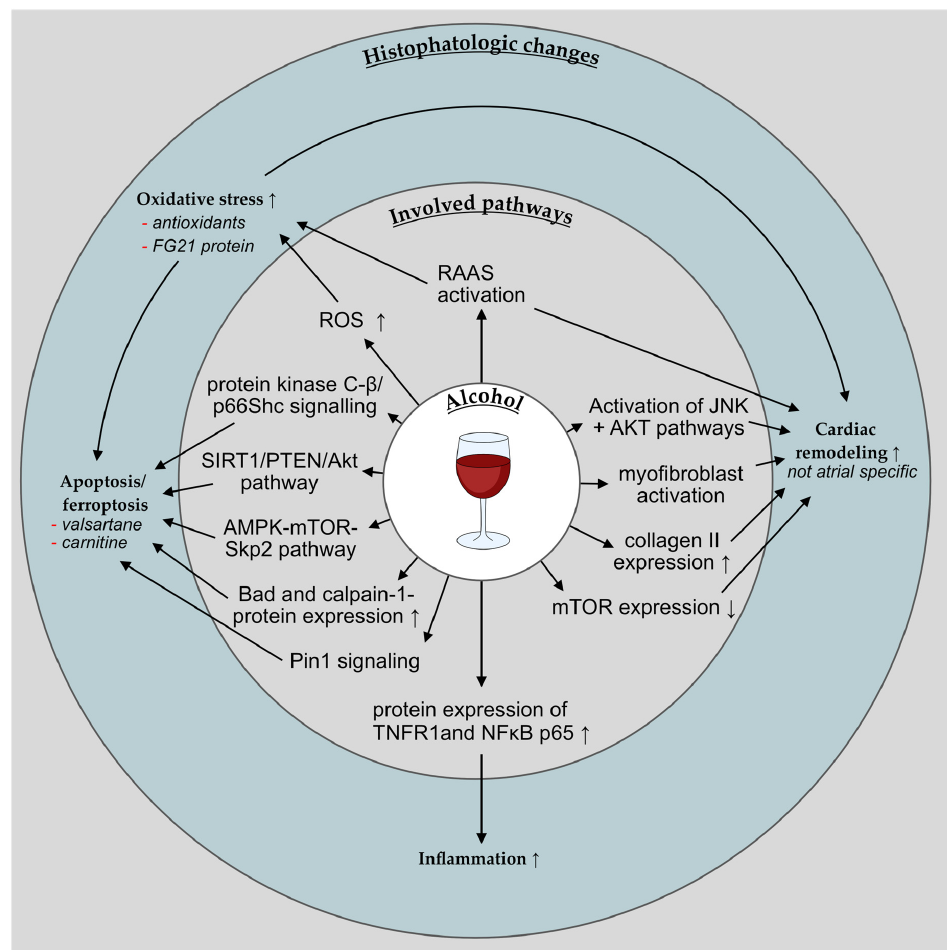
Figure 5. Simplified overview over the histopathologic changes in the atrium that are associated with alcohol and the involved pathways. ↑ indicates an increase and ↓ a decrease of the respective aspect, —an attenuation of a certain